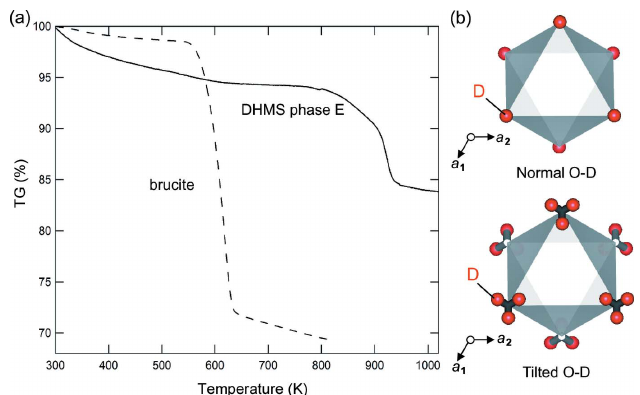
Figure 1 ( a ) Thermogravimetry results of DHMS phase E [Mg 3 (cid:2) 0.5 x Si x H 6 (cid:2) 3 x O 6 ] and brucite [Mg(OH) 2 ] measured at ambient pressure using Rigaku Thermo plus EV02. The former structure retains most of its hydrogen at around 900 K, while the latter retains it at around 600 K. We consider that the difference in dehydration temperatures between these minerals is related to the difference in their hydrogen bonding strengths. ( b ) Two equally plausible hydrogen site models that have been adopted so far for DHMS phase E (Tomioka et al. , 2016). Each corner of the octahedra is made of an oxygen anion (not shown). In the normal O—D model, the dipole is parallel to the c axis and normal to the MgO 6 octahedral layers. In the tilted O—D model, the dipole is tilted from the c axis. The crystallographic illustrations were created using the software VESTA3 (Momma & Izumi,